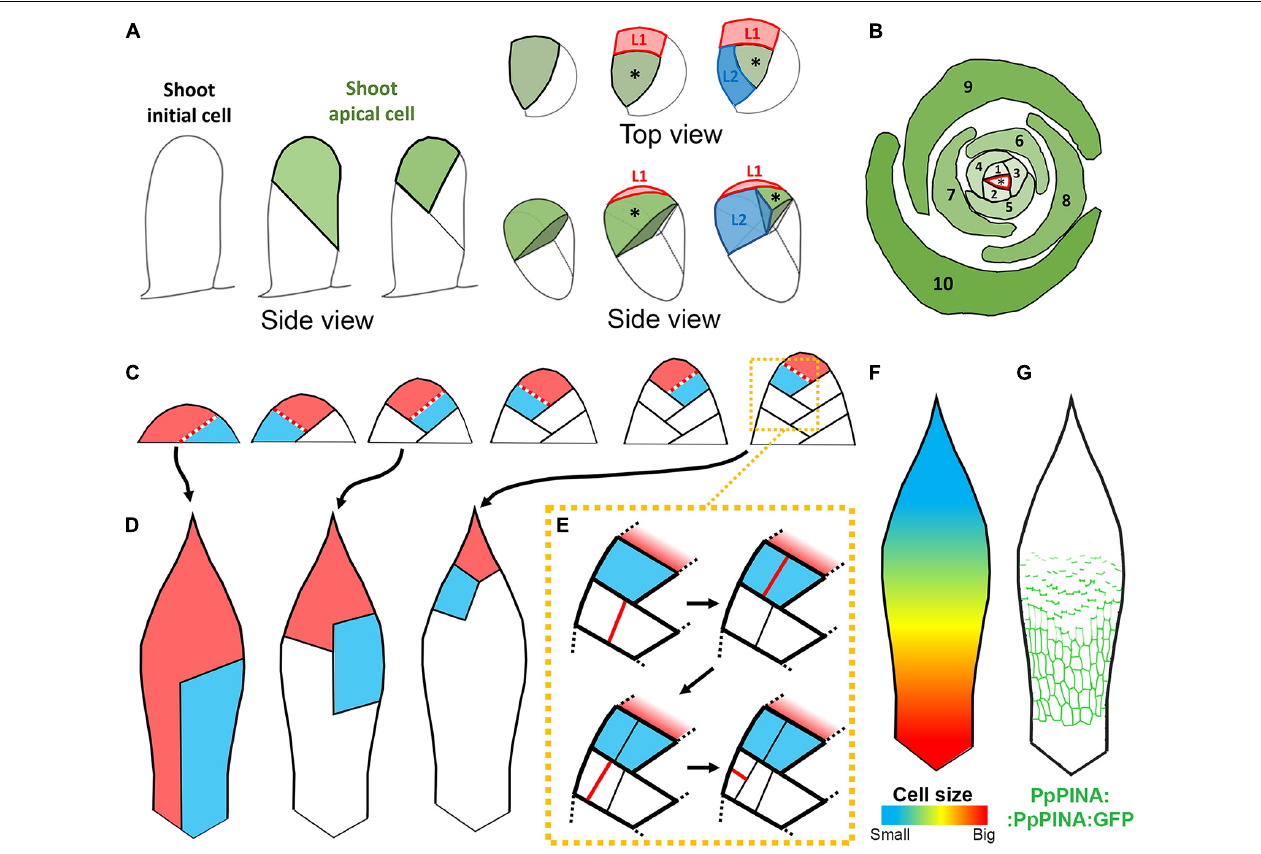
FIGURE 2 | Leaf growth in P. patens. (A) Schematic representation of the transition from 2D to 3D growth during leafy gametophore initiation. Gametophore shoot initial cell divides obliquely to generate the shoot apical cell (in green). Second and third divisions of the shoot initial cell are also oblique and generate a hair cell (in white) and the first leaf initial (L1, in red) consecutively. From this stage, the shoot apical initial cell becomes tetrahedral and generates subsequent leaf initials. (B) A single apical cell (marked with asterisk) produces leaves in a spiral phyllotactic pattern with leaf sequences indicated in consecutive numbers. (C) Schematic representation of the early development of the juvenile leaf. The leaf apical cell is shown in red and the cell recently cleaved from the apical cell is shown in blue. Red dotted lines indicate recent cell division (based on Harrison et al., 2009). (D) Schematic representation of clonal sectors arising from single cells shown in (C) at early stages of leaf development. (E) Schematic representation of cell division patterns within the segments generated by the leaf apical cell. Red lines represent new walls (based on Harrison et al., 2009). (F) Schematic representation of the distribution of cell sizes in the adult leaf. Bigger cells are located in the distal region of the leaf, smaller cells in proximal region (based on Dennis et al., 2019). (G) Schematic representation of the PpPINA protein localization (in green) in the adult leaf (Viaene et al.,